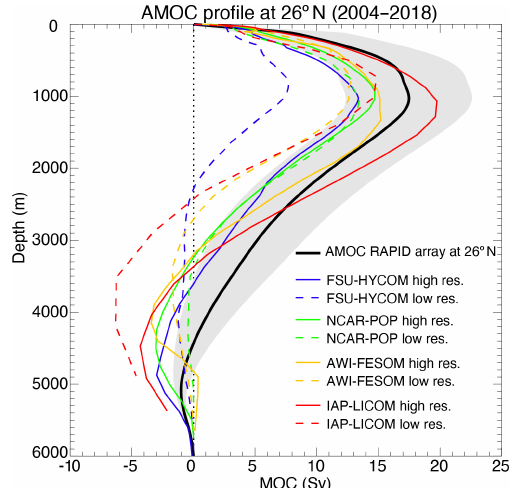
Figure 27. AMOC profile at 26 ◦